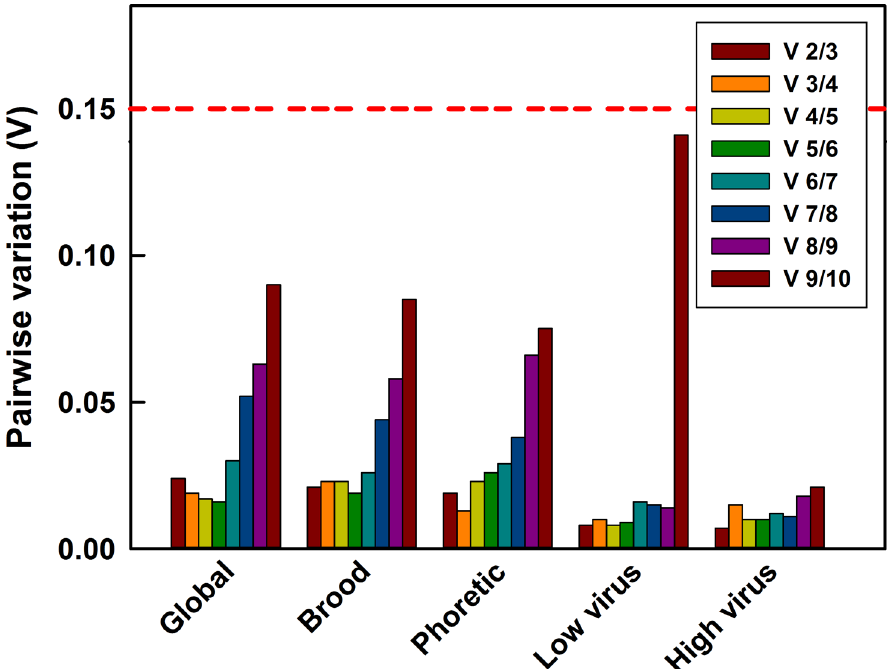
Fig 3. Pairwise variation analysis to determine optimum number of reference genes for accurate normalization. A pairwise variation analysis (geNorm) globally for all samples (n = 12) as well as subset analysis on brood mite samples (n = 3), phoretic mites (n = 3), Low virus mites (n = 3) and High virus mites (n = 3). Each sample comprised 8 pooled mites. Pairwise variation is compared with 0.15, below which the inclusion of a subsequent reference gene is not necessary to ensure accurate